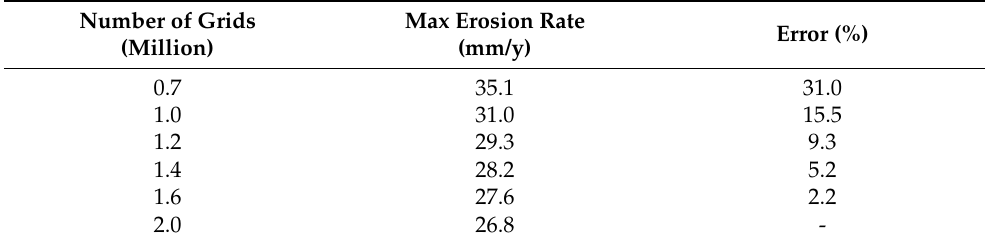
Table 3. Validation of the grid independence of the